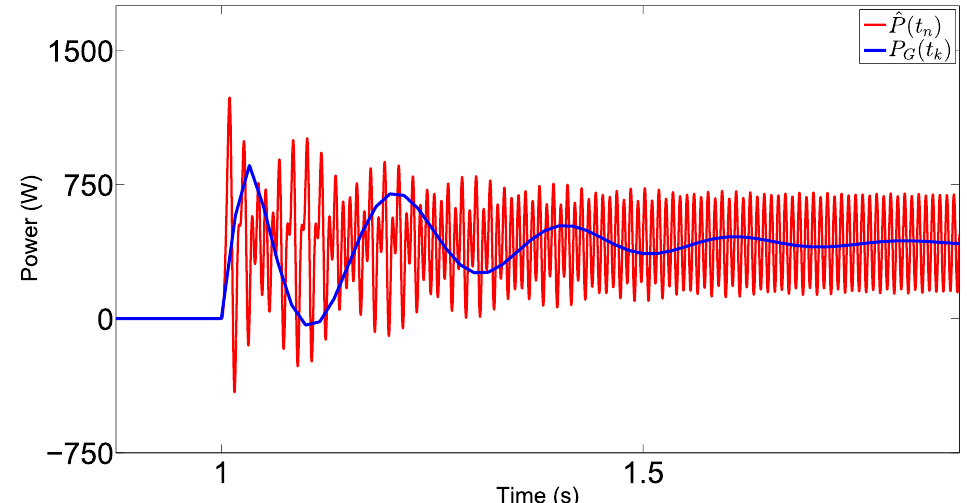
Figure 9. GOLD method performance for an unbalanced load: Correct power demodulation P G ( t k ) despite harmonics in instantaneous power P ( t k )